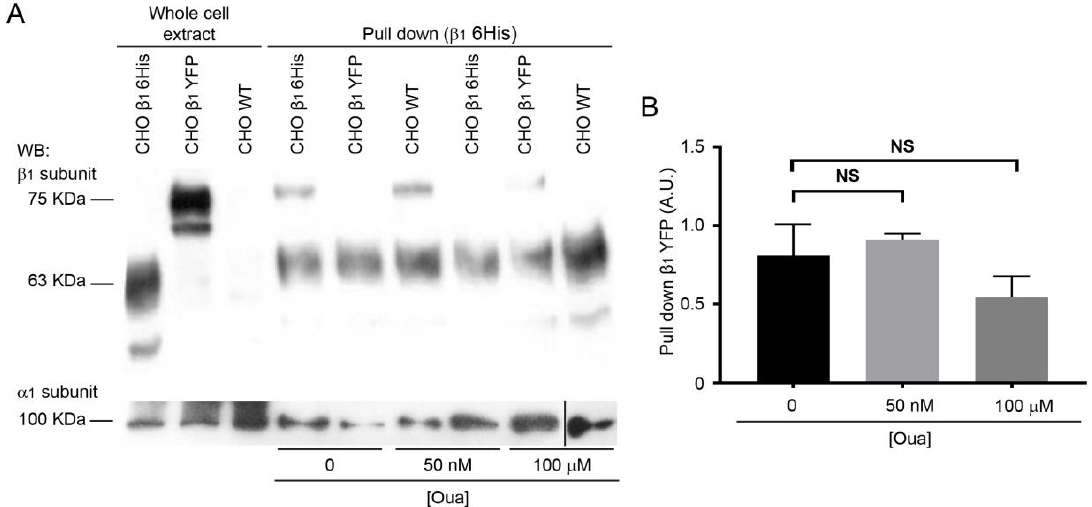
Figure 3. A direct interaction between ouabain and the α 1 subunit of Na + ,K + -ATPase is not sufficient for the observed adhesive phenotype. ( A ) Western blot analysis of β 1 and α 1 subunits of the Na + ,K + -ATPase: cell lysate of CHO β 1 6His, CHO β1 YFP and CHO WT cells (three left lanes); Pull Down assay between CHO β 1 6His as a bait and CHO β 1 YFP or CHO WT as a prey with 0 nM, 50 nM and 100 µM Ouabain (six right lanes). The 63 KDa band corresponds to the β 1 6His, and the higher-molecular-weight band corresponds to the β 1 YFP (75 KDa), both recognized by the same anti-β 1 subunit antibody. ( B ) Densitometric quantification of the results presented in A. In pulled down fractions, the density of the β 1 YFP band was normalized with the β 1 6His band. Data represent the mean of three independent replicates. Kruskal Wallis and Dunn’s test for multiple comparisons were performed. Error bars, ± SE; NS, non-signigicant .